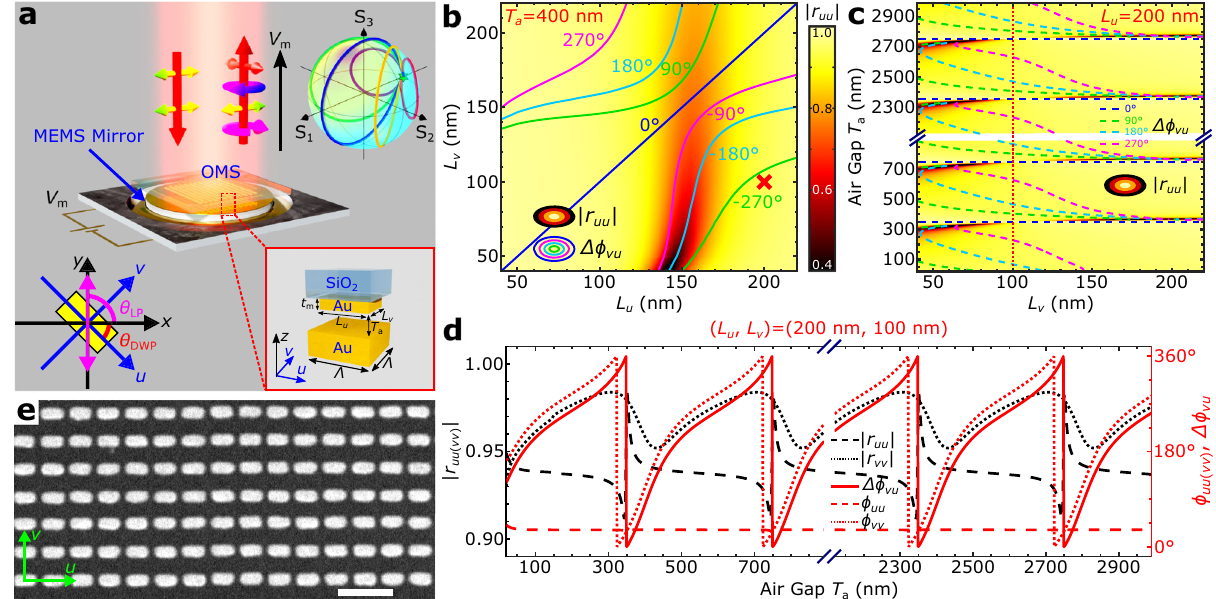
Fig. 1 Electrically controlled MEMS-OMS-based DWP. a Schematic of the dynamic wave plate (DWP) component consisting of an optical metasurface (OMS) on a glass substrate, mounted on a movable micro-electro-mechanical system (MEMS) mirror. By applying a voltage V m , the separation between the MEMS mirror and OMS can be changed, thereby achieving a continuously variable birefringence in re fl ection. The bottom-right inset is a close-up view of the MEMS-OMS unit cell representing a gold nanobrick on glass separated by an air gap T a from the MEMS gold mirror. The top-right inset illustrates, with the Poincaré sphere, different re fl ected fi eld polarization trajectories that can be realized by changing V m for the fi xed incident linear polarization (LP) state | y > ( θ LP = 90°) and fi ve different DWP orientations ( θ DWP = 15°, 30°, 45°, 60°, 75°). The coordinate systems used are shown in the bottom-left inset. b Re fl ection amplitude (| r uu |) and bi r efringence ( Δ ϕ vu ) calculated as a function of the nanobrick side lengths L u and L v , for the air gap T a = 400 nm, with other parameters as follows: λ = 800nm, t m = 50 nm, Λ = 250 nm. Color map is related to the re fl ection amplitude, while colored lines represent constant birefringence contours. The red cross indicates the selected nanobrick dimensions L u × L v = 200 nm × 100 nm. c Re fl ection amplitude (| r uu | ) and bi r efringence ( Δ ϕ vu ) calculated as a function of the nanobrick side length L v and air gap T a , for the other side length L u = 200 nm. Color map is related to the re fl ection amplitude, while colored dashed lines represent constant birefringence contours. The vertical, red dotted line corresponds to the selected nanobrick dimensions L u × L v = 200 nm × 100 nm. d Re fl ection amplitudes | r uu ( vv ) | (black dashed and dotted), phase ϕ uu ( vv ) (red dashed and dotted), and birefringence Δ ϕ vu (red solid) calculated as a function of the air gap T a for the selected nanobrick dimensions L u × L v = 200 nm × 100 nm. e Scanning electron microscopy (SEM) image of a part of the OMS nanobrick array fabricated on the glass substrate. The scale bar is 500